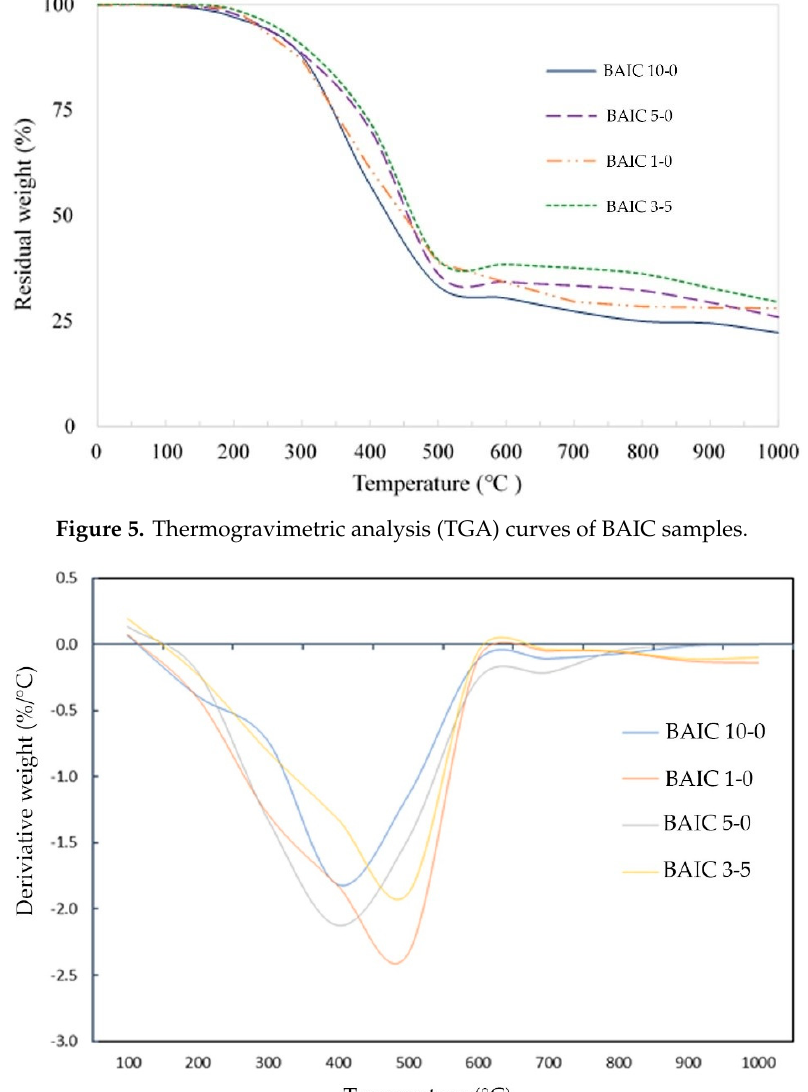
Table 3. Potential compound present in BAIC samples, decomposition reaction and temperature.